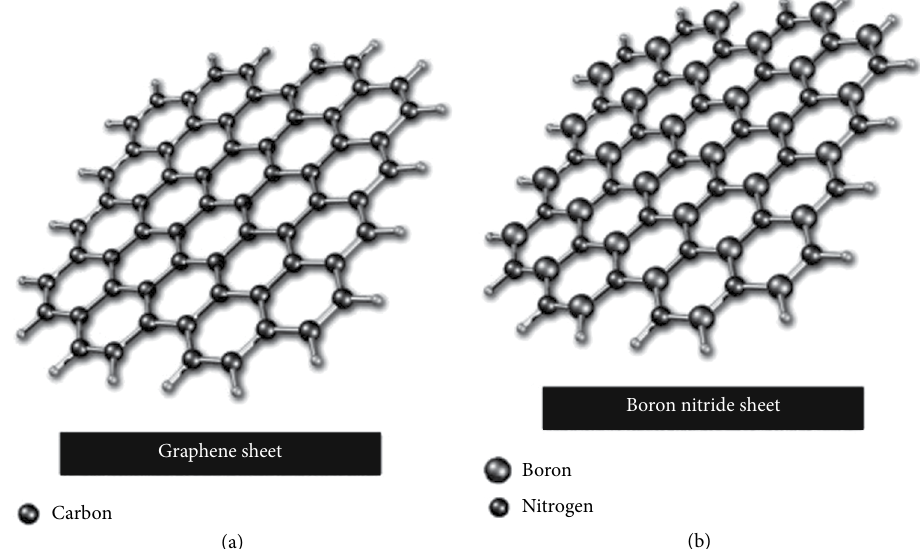
Figure 4: Schematic representation of the structure of graphene (a) and boron nitride (b). Adapted from